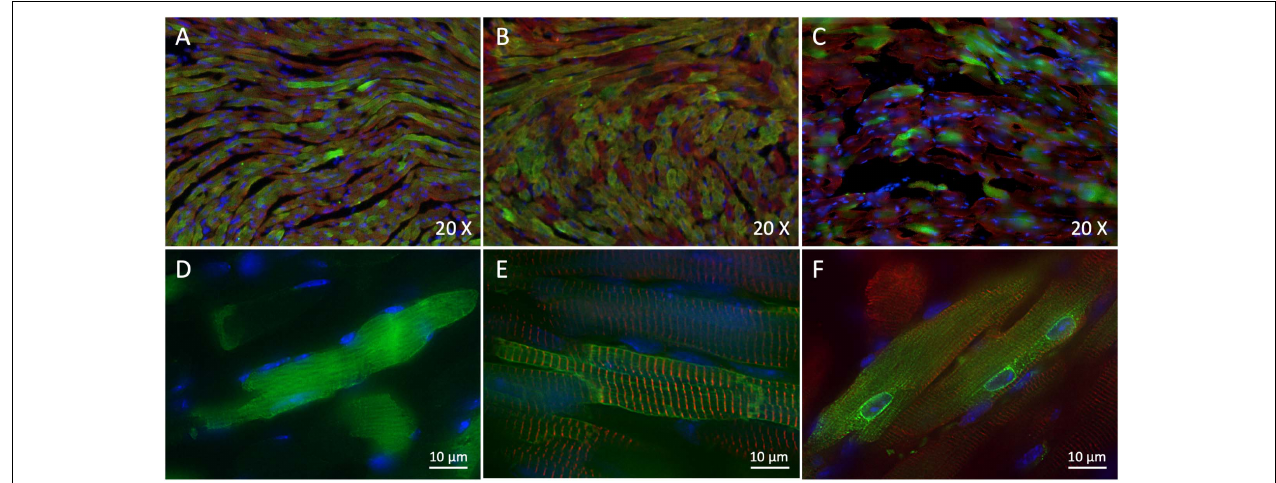
FIGURE 2 | Trans -splicing dual AAVs efficiently transduce heart tissue. (A,D) Representative 3-dimensional deconvolution images of GFP (green) and α -actinin 2 (red) immunostaining of 10 µ m GFP-injected mouse heart cryosections. (A) : 20 × ; (D) : 60 × ; scale bar: 10 µ m. (B,E) Representative 3-dimensional deconvolution images of hNa v 1.5 (green) and α -actinin 2 (red) immunostaining of 10 µ m hNa v 1.5-injected mouse heart cryosections. (B) : 20 × ; (E) : 60 × ; scale bar: 10 µ m. (C,F) Representative 3-dimensional deconvolution images of hNav1.5-R104W (green) and α -actinin 2 (red) immunostaining of 10 µ m R104W-injected mouse heart cryosections. (C) : 20 × ; (F) : 60 × ; scale bar: 10 µ m. Exogenous hNa v 1.5-GFP channels were stained in green by the anti-GFP antibody, and nuclei in blue using DAPI. Note that AAV-GFP transduced approximately 75% of injected mice cardiomyocytes, as did the trans -splicing AAVs expressing hNa v 1.5, while the hNav1.5-R104W mutant channels were observable in around 1/3 of heart cells. The GFP protein was expressed in the whole cytoplasm of transduced cells, whereas the hNa v 1.5 channels were expressed at the cell surface and hNa v 1.5 channels carrying the R104W variant were mostly retained in the perinuclear area of